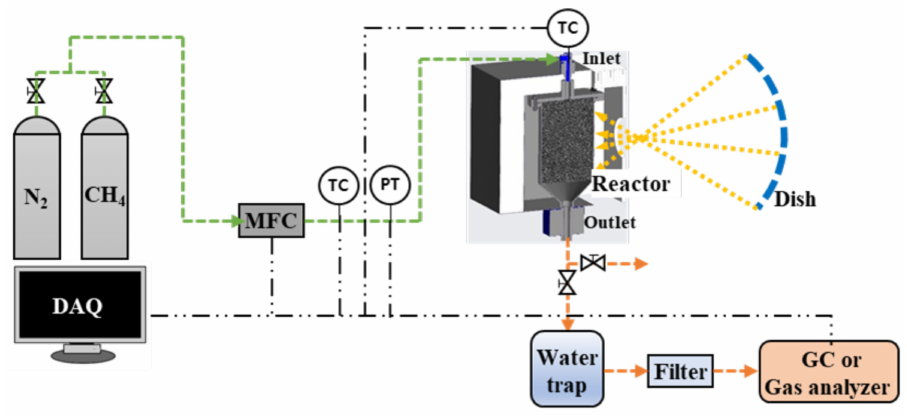
Figure 4. Schematic diagram of the experimental